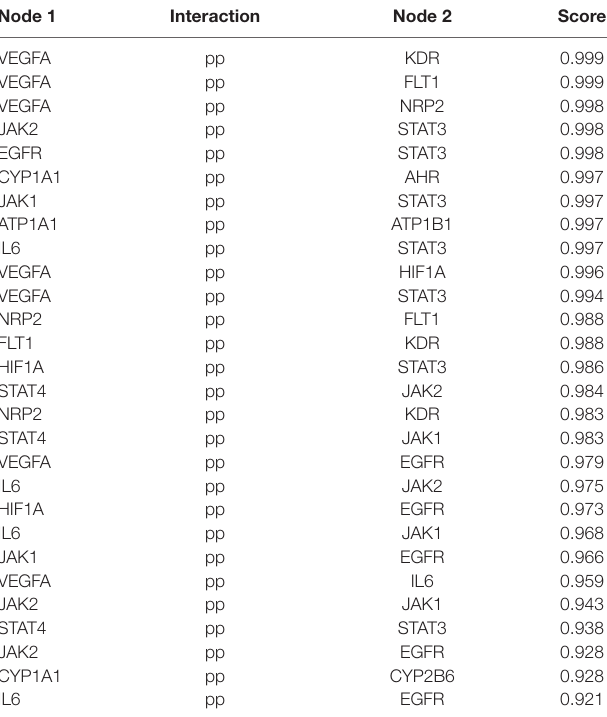
TABLE 4 | The proteins interacting of hub targets.